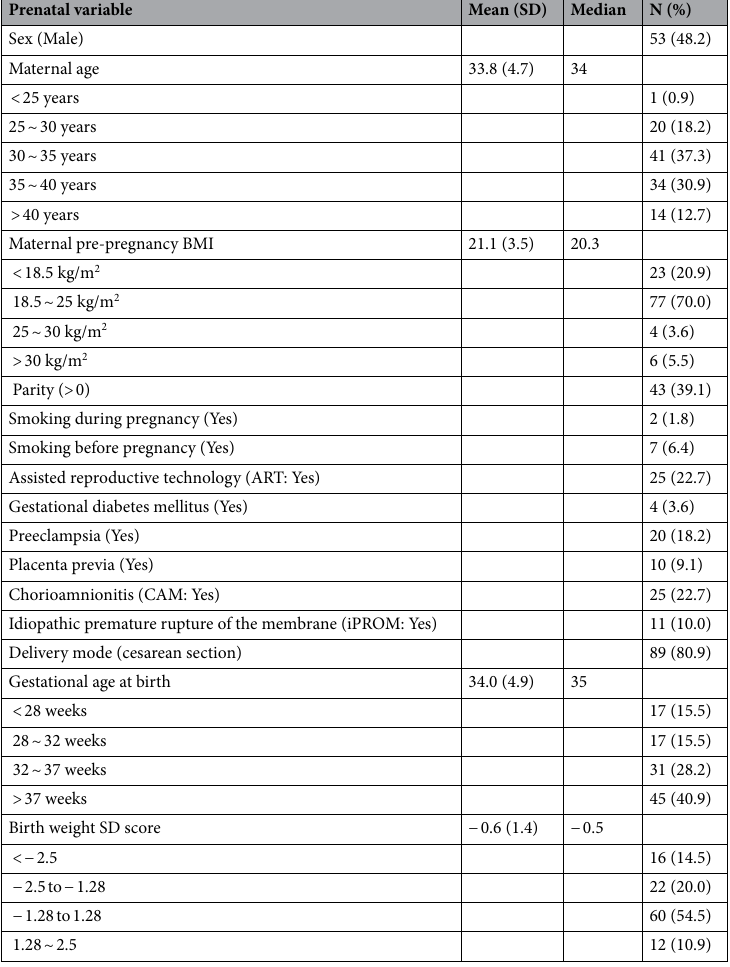
Table 1. Pregnancy- and delivery-related characteristics of 110 mother-infant pairs. *Since the table containing all the values exceeds one page, other descriptive characteristics that cannot be written in Table are shown in Supplementary Table